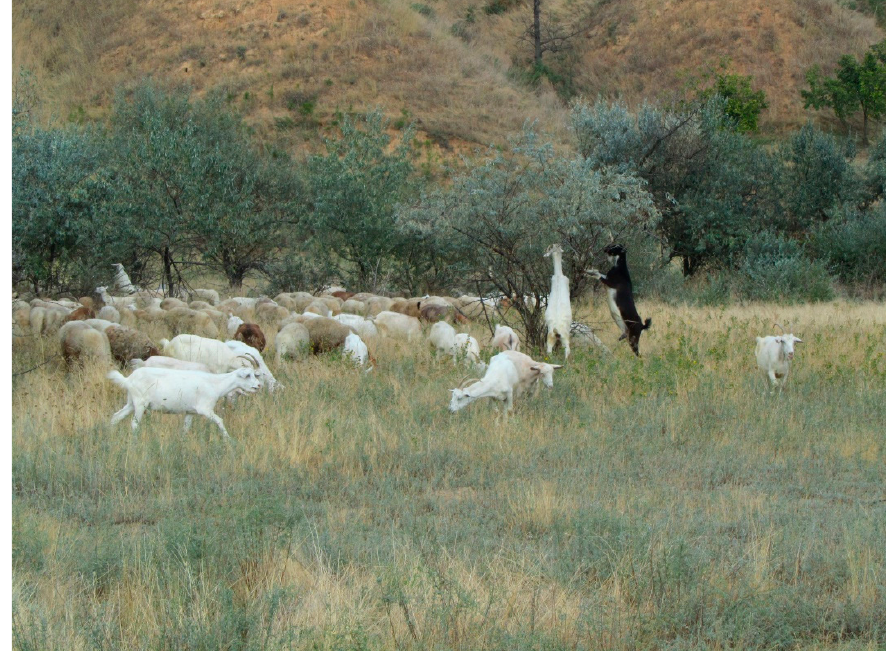
Figure 24. Pasture degradation of vegetation (surroundings of Kubanka village).